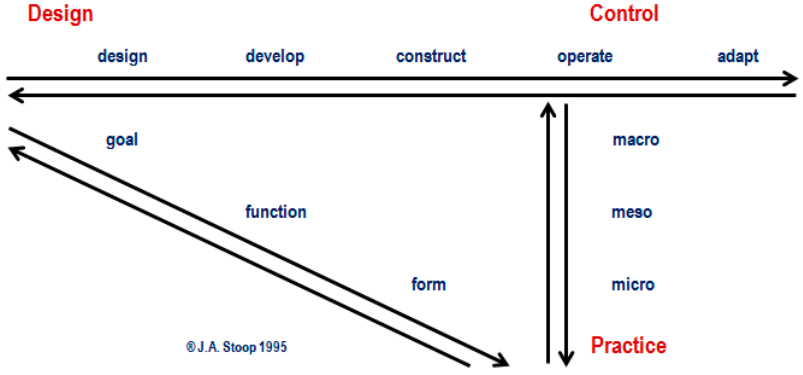
Figure 4. The Design-Control-Practice (DCP) Diagram by Stoop (Source: [16]).